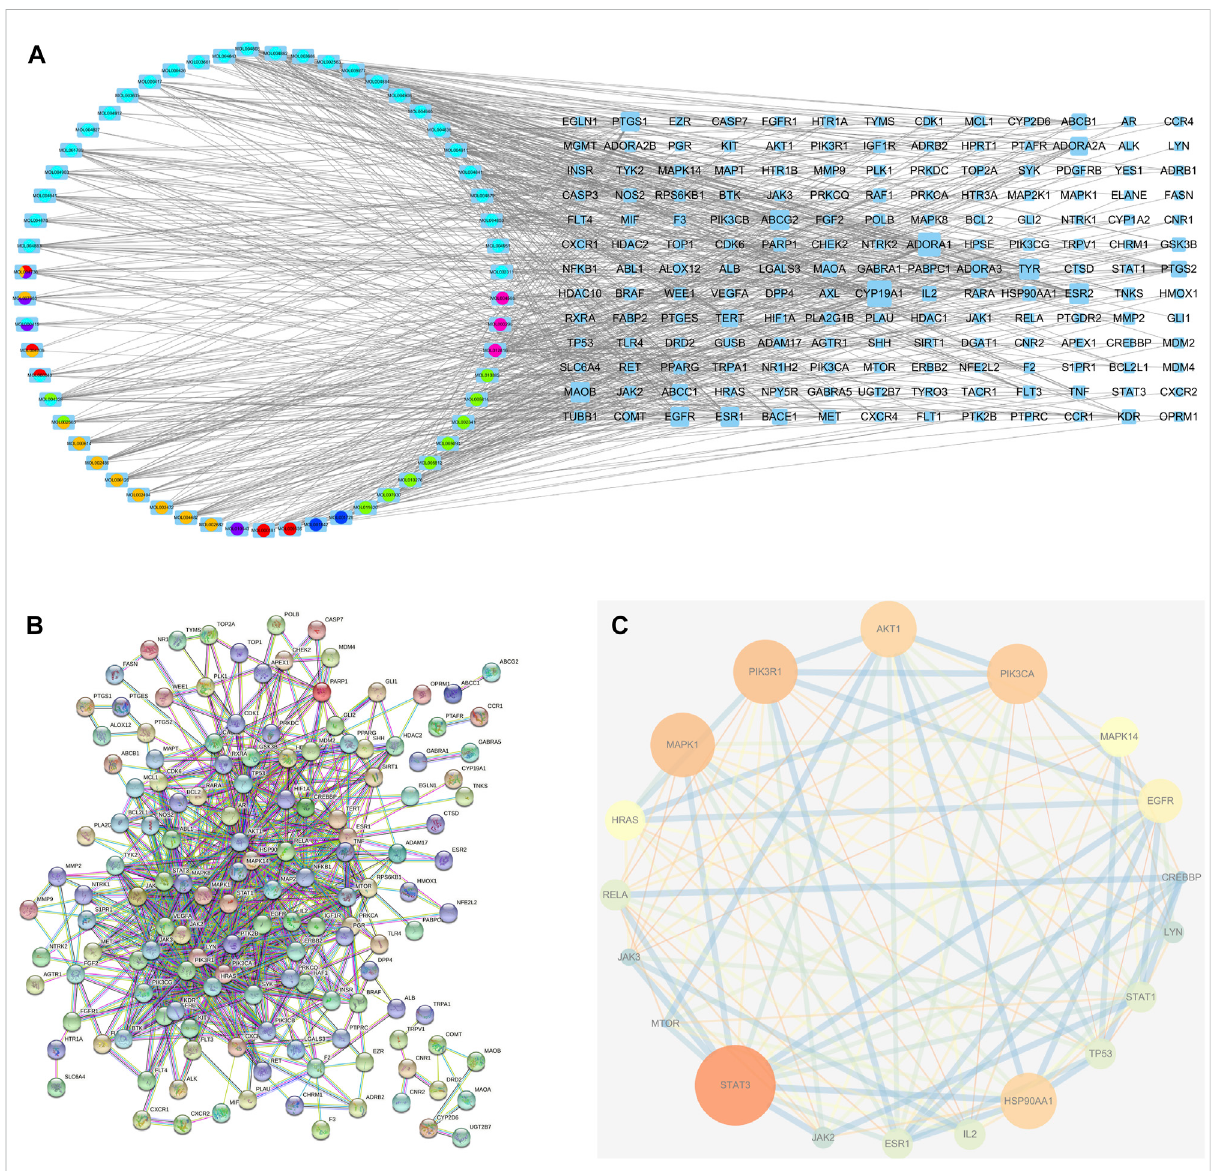
FIGURE 5 (A) “ Ingredient-target ” interaction network (B) Protein-protein interaction network of LJAW in the treatment of gastrointestinal reactions caused by chemotherapy for colorectal cancer. (C) Selected 18 core